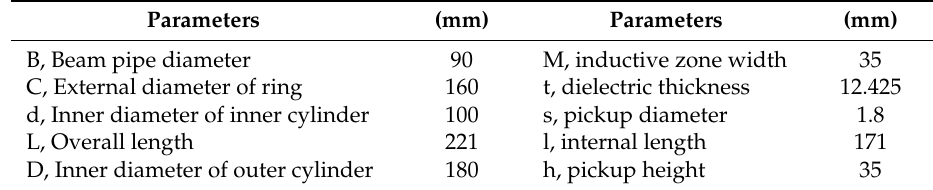
Figure 5. Dielectric-filled reentrant cavity resonator as beam current monitor. The pickups in the figure represent the large magnetic loops in one plane (as port 3 and 5). Two small magnetic loops are in the other plane (as port 4 and 6). Port 1 is the beam entrance and Port 2 is the beam exit. Table 2. Parametric dimensions of the reentrant cavity resonator.